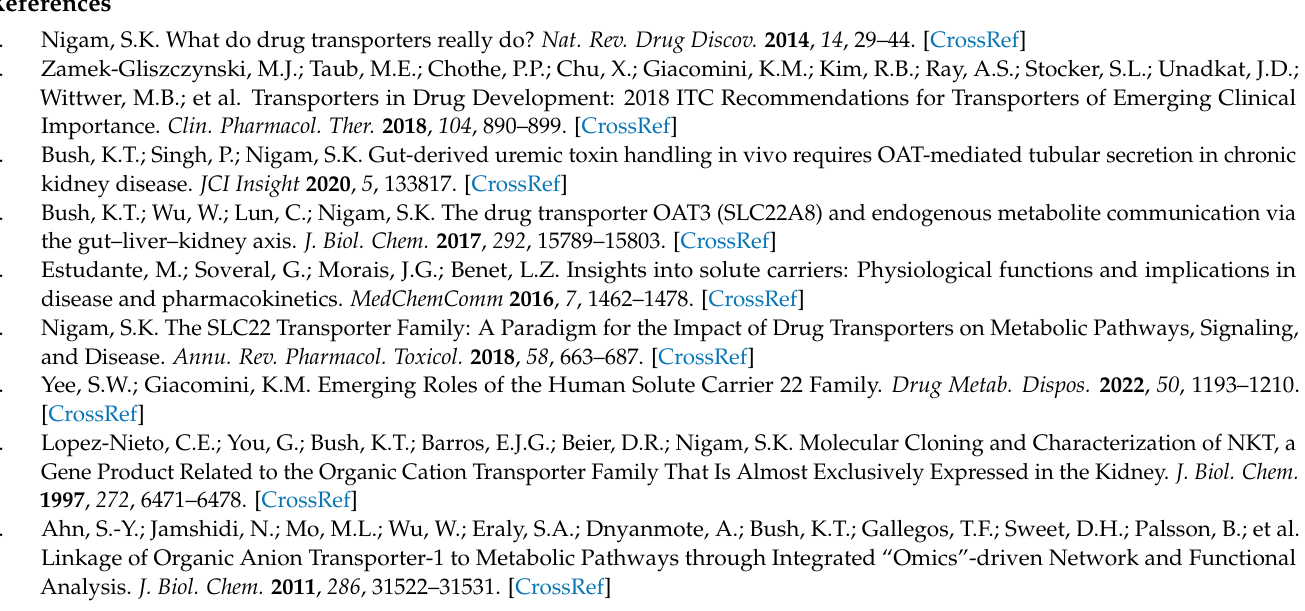
Table S6: Summary of DE ADME genes in comparisons of pathologic variable classes in KIRC and KIRP; Table S7: Metrics for networks of SLC22 and interacting genes Metrics for networks of SLC22 and interacting